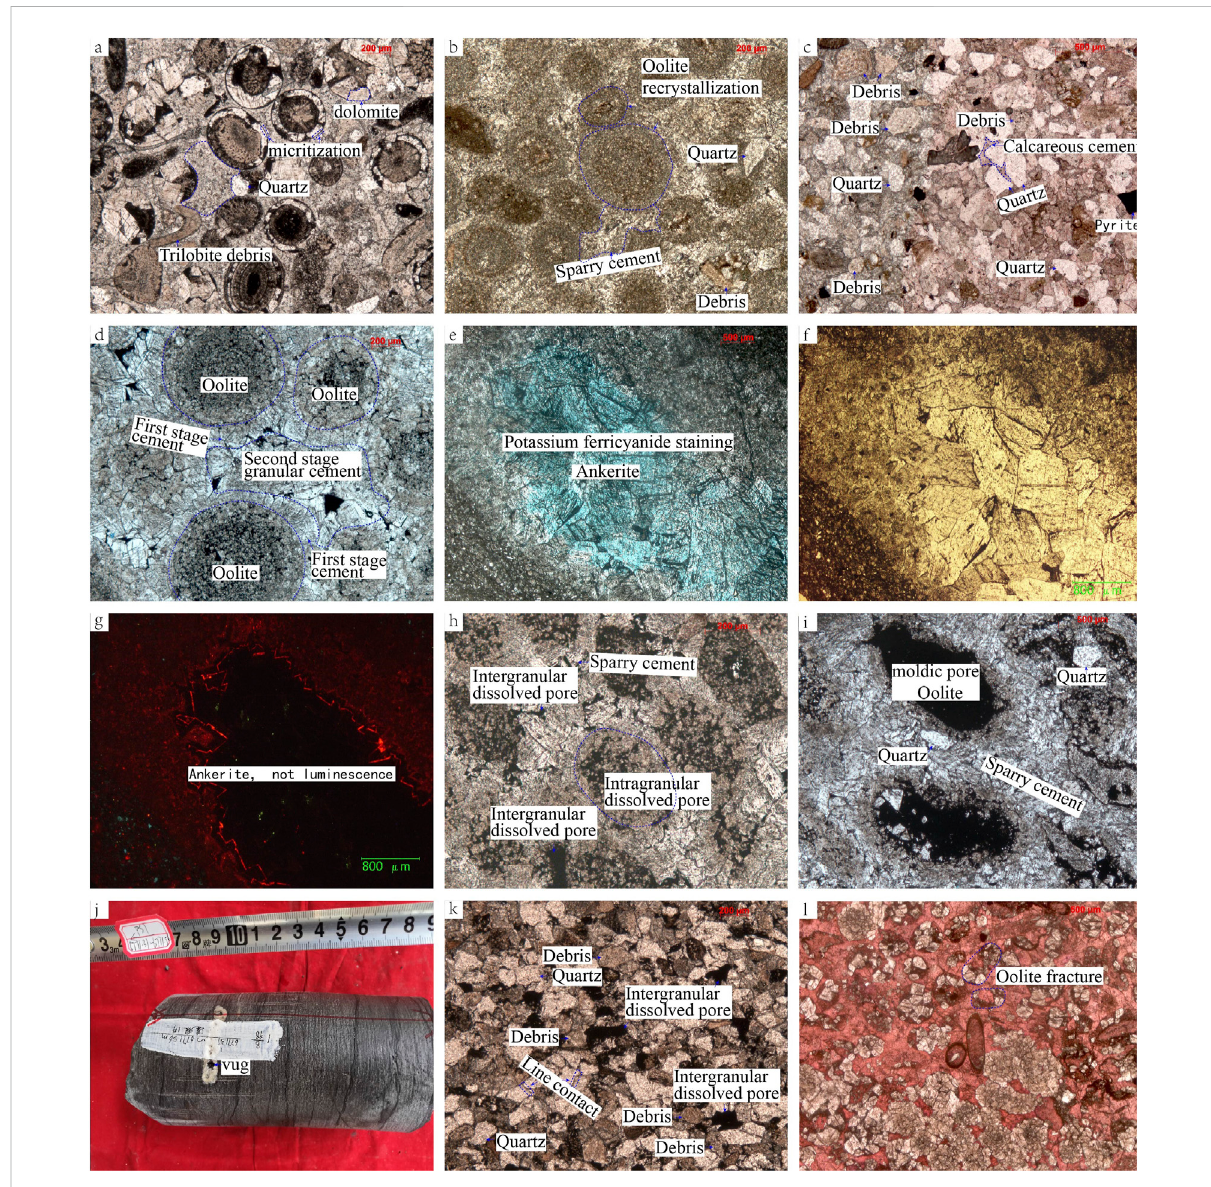
FIGURE 3 Developmental characteristics of typical diagenesisin the study area. (A) Micritic sleeves formed by micritization. Dolomite sparry oolitic limestone, Well CT1, 6275.63 m, single polarized light, dyed cast thin section; (B) Weak recrystallization occurs inside the oolites. Sparry oolitic dolomite, well PT101, 5018.1 m, single polarized light, dyed cast thin section; (C) Calcareous cementation at the edges of quartz grains. Calcareous fi ne-grained detrital sandstone, Well PT101, 5023.14 m, single polarized light, dyed cast thin section; (D) Horse tooth-like cement and granular cement. Sparry oolitic dolomite, Well DB1, 5938.9 m, single polarized light, dyed cast thin section; (E) The second phase of ankerite cement. Argillaceous silty dolomite, Well DB1, 5951.7 m, single polarized light, potassium ferricyanide dyed thin section; (F) Unstained thin section of sample e; (G) Cathodoluminescence imageof sample e, thesecond phase ankeritecement doesnot emit light; (H) Intergranular dissolution (yellow arrows) and intragranular dissolution pores (red arrows) formed by dissolution. Sparry oolitic dolomite, CT1 well, 6264.53 m, single polarized light, dyed cast thinsection; (I) Moldporesformedbydissolution.Sparryooliticdolomite,WellCT1,6268.9 m,singlepolarizedlight,dyedcastthinsection; (J) Pores formed by dissolution, and they are mostly half fi lled with calcite. Gray sand-bearing oolitic dolomite, Well PS1, 6771.31 – 6771.56 m, core photo; (K) Intergranular pores formed by dissolution. Fine-grained detrital sandstone, Well DB1, 5913.45 m, single polarized light, dyed cast thin section; (L) Oolitic broken dolomitic oolitic limestone. Well CT1, 6285.76 m, single polarized, dyed cast thin